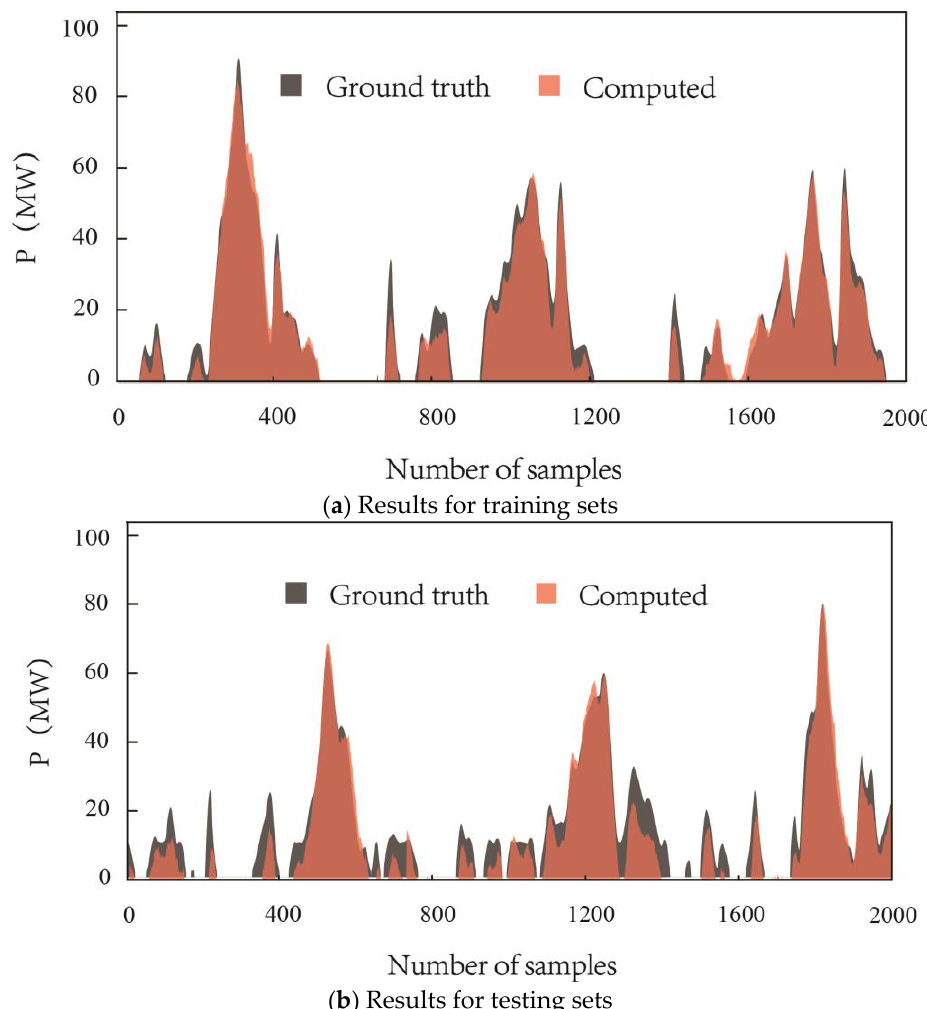
Figure 7. Comparison of The Ground Truth Power and Predicted Power of Four Devices.